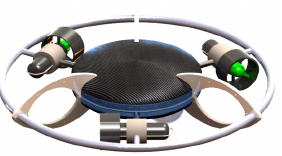
Figure 6. Smart-E. Modern thruster-driven AUV, which is declared to be highly efficient